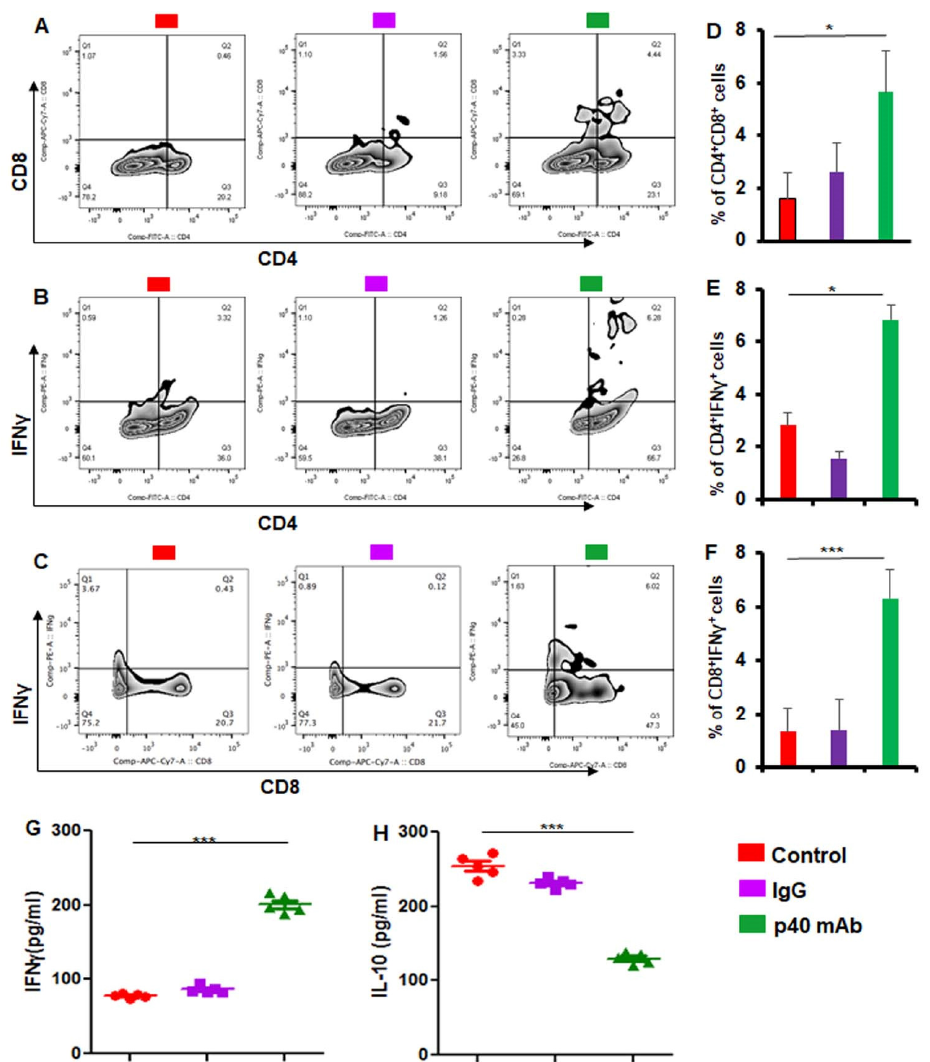
Figure 5. Stimulation of adaptive immune response in spleen of PDX mice by p40 mAb treatment. Female 6–8 week old NSG mice were engrafted TNBC tumor in the flank. After about 4 weeks of engraftment, when tumors of PDX mice were 0.6-0.8 cm 2 in size, mice were treated with p40 mAb and hamster IgG at a dose of 2 mg/kg body wt once a week. After 2 weeks of treatment, spleens were harvested and levels of human CD4 + CD8 + ( A ), CD4 + IFN γ + ( B ) and CD8 + IFN γ + ( C ) T cells were monitored in splenocytes by FACS using a BD LSRFortessa™ cell analyzer. Percentages of human CD4 + CD8 + ( D ), CD4 + IFN γ + ( E ) and CD8 + IFN γ + ( F ) T cells were calculated. Results are mean ± SEM of five mice ( n = 5) per group (one analysis per mouse). Levels of human IFN γ ( G ) and IL-10 ( H ) were measured in serum of all groups ( n = 5) of mice by sandwich ELISA. * p < 0.05; *** p <